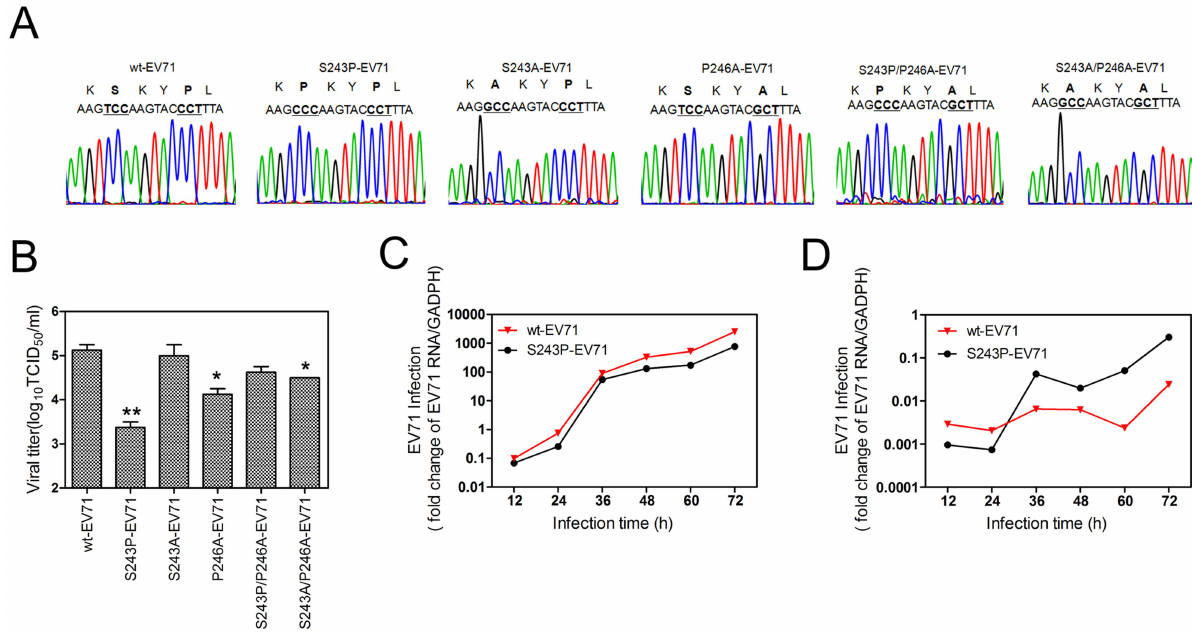
Figure 6. An analysis of various H-I loop mutant viruses. (A) A sequencing chromatogram of the mutated H-I loop region. (B) Viral titers in the supernatant were measured at 48 hpi after the transfection of EV71 mutant viral RNA. Each column represents the average of two replicates. Error bars represent the SEM * 0.01 , P , 0.05 and ** P # 0.01, by an independent sample t-test (2-tailed) when compared with wt-EV71. The growth curves of wt-EV71 and S243P-EV71 in RD cells at an MOI of 0.1 without (C) or with (D) inhibitor HL051001P2 treatment. The EV71 infection was quantified by using qRT-PCR to detect the EV71 RNA in cells at different times post infection, and the mRNA level of GAPDH was used as an internal control.